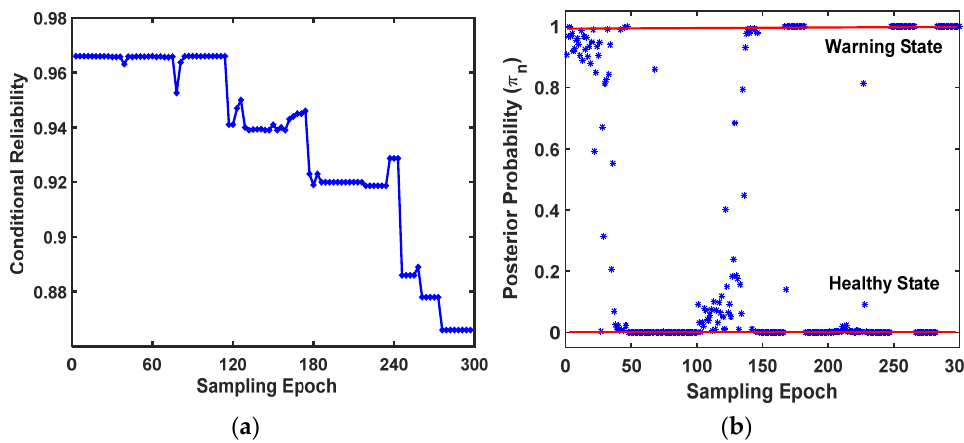
Figure 8. ( a ) Trend of the conditional reliability as a function of the sampling epoch estimated at the 100th iteration; ( b ) the posterior probability trend of transition to warning state for the oil degrada- tion data with frequent oil replenishments and oil